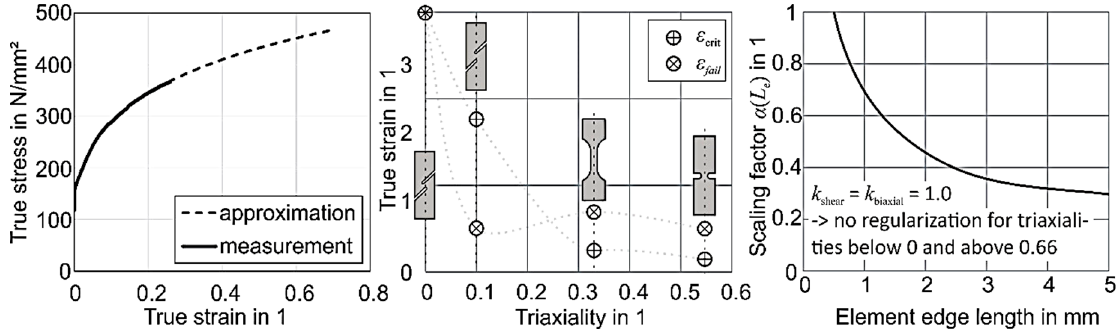
Figure 14. Results of the quasistatic analysis of DC06. Left: Flow curve. Middle: Failure strain and critical strain (starting of damage) of the GISSMO model. Right: Determined regularization curve.